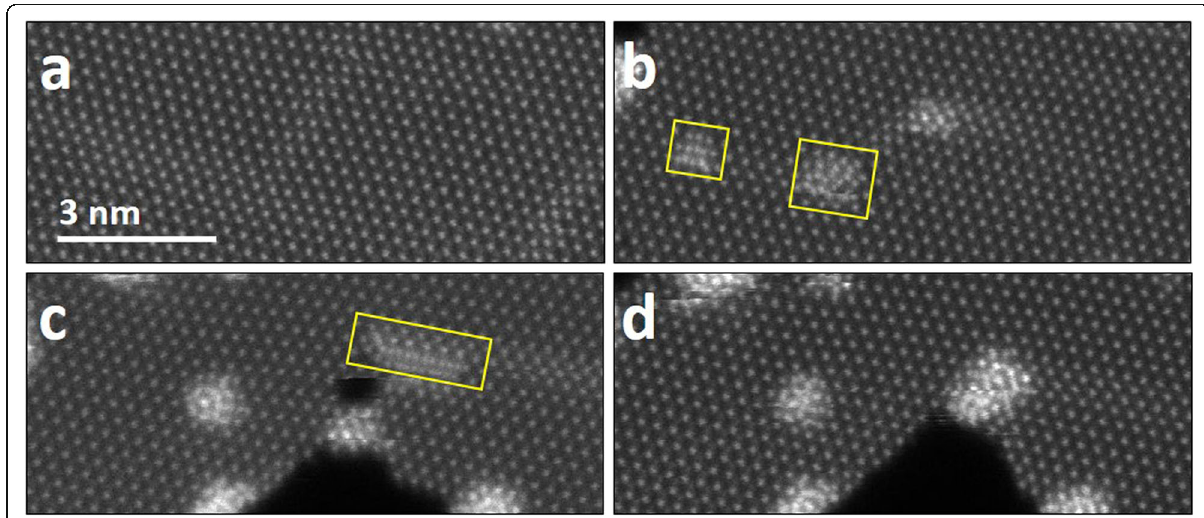
Fig. 4 Transport of W atoms along line defects. a ADF-STEM image showing the WS 2 sheet. b – c ADF-STEM images showing transport W atoms. Yellow boxes indicate transporting W atoms to form clusters. d Transition from the transporting atoms into the intermediate phase at the edge of the